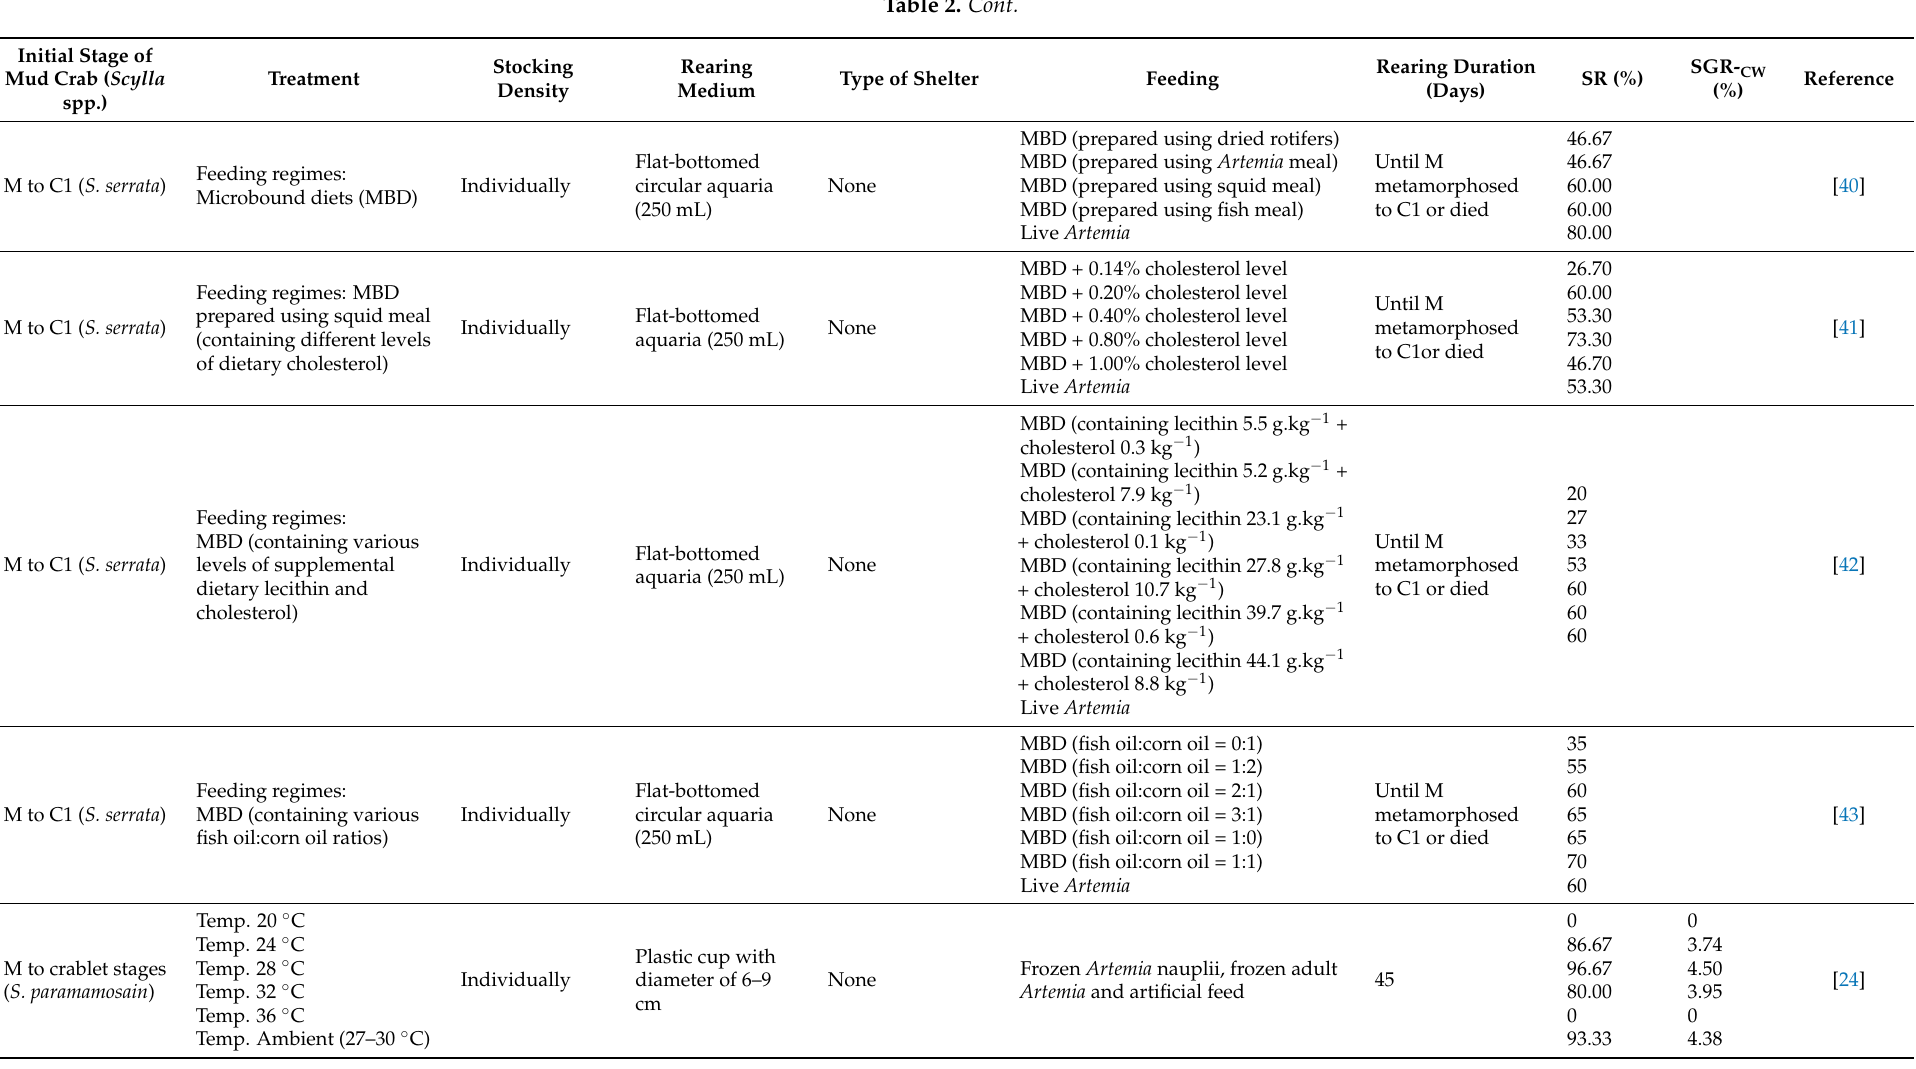
Initial Stage of Mud Crab ( Scylla